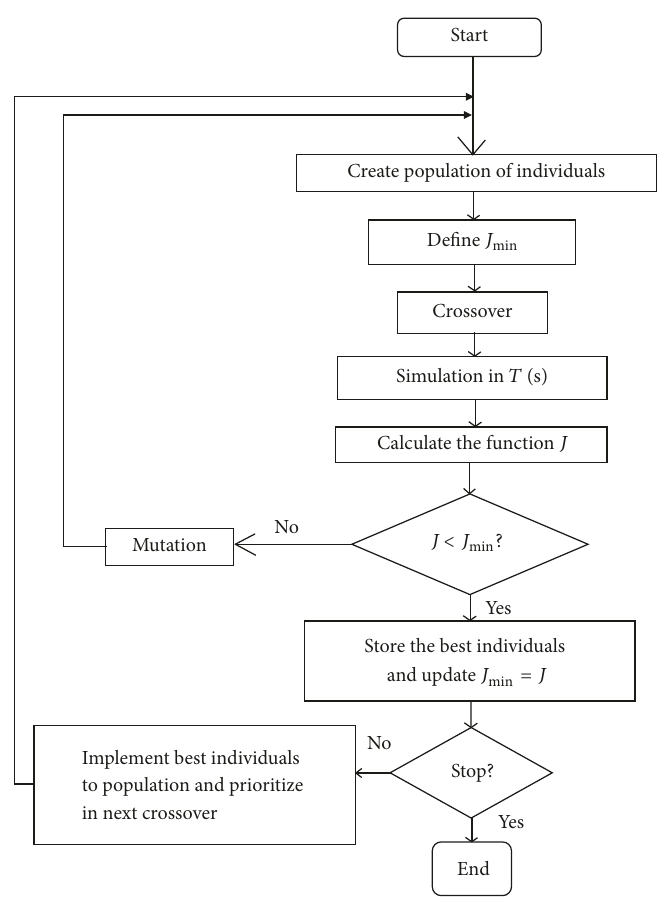
Figure 12: Flowchart of genetic calculation